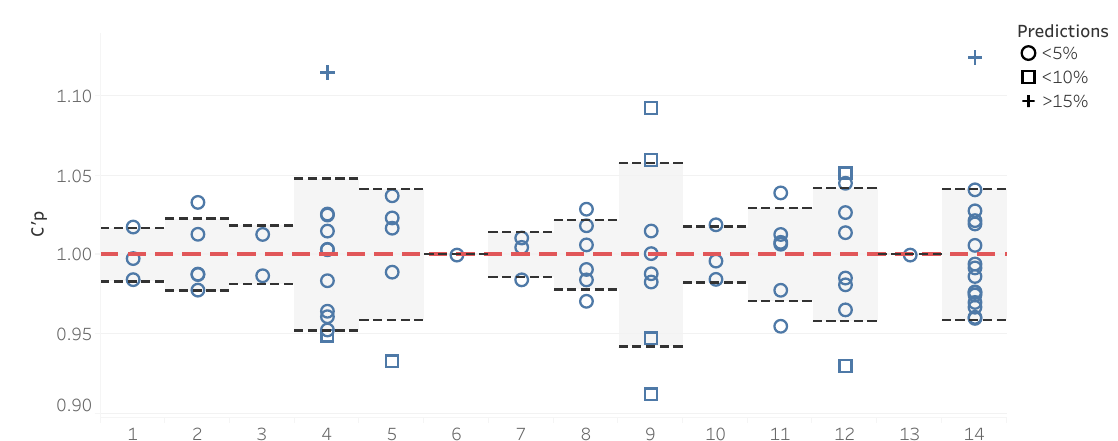
Figure 16. Illustration of the speed trial spread between sister ships for 14 ship series. C (cid:48) each series. Dashed black lines indicates the standard